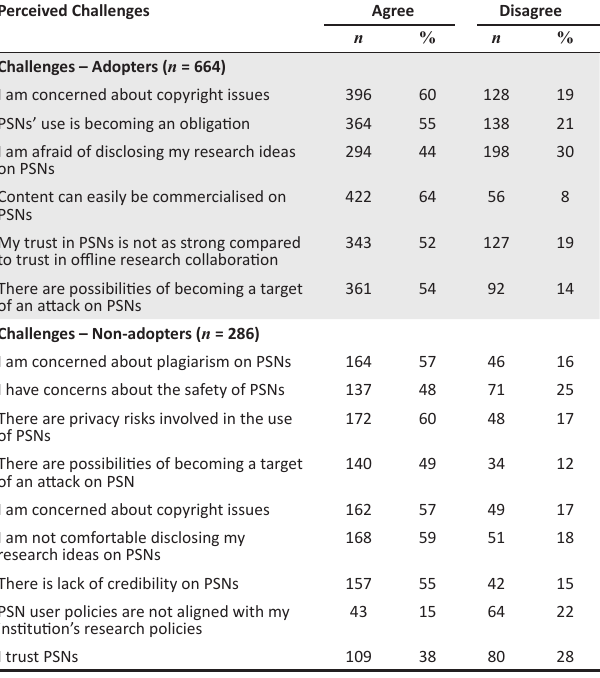
TABLE 3: Perceived challenges of professional social networks. Perceived